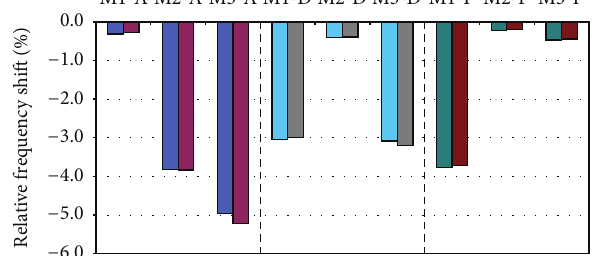
Table 3: Natural frequencies analytically derived for wide affected region